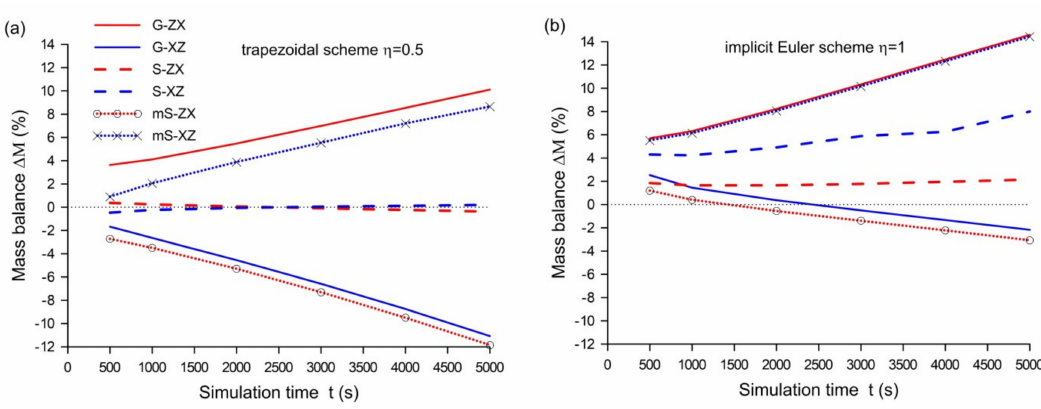
Figure 8. Mass balance error ∆ M vs. simulation time for various splitting algorithms ( ∆ t = 5 s) with the implicit trapezoidal scheme ( η = 0.5) ( a ) and the implicit Euler scheme ( η = 1) ( b